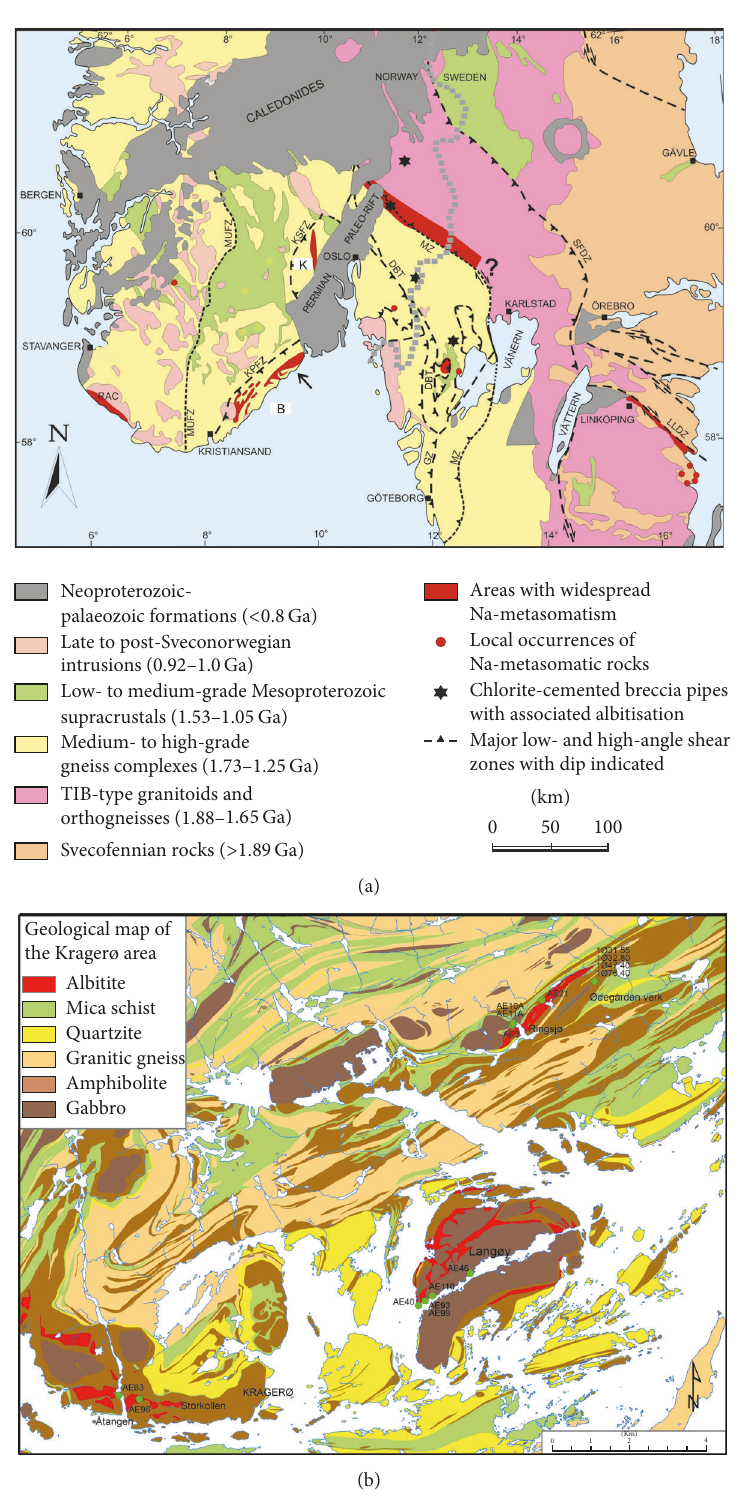
Figure 1: (a) Regional geological map of south Norway and Sweden indicating areas of widespread Na-metasomatism [23]. Arrow indicating the study area (Figure 1(b)). B = Bamble lithotectonic domain; K = Kongsberg-Modum lithotectonic domain; RAC = Rogaland Anorthosite Complex; KPFZ = Kristiansand-Porsgrunn Fault Zone; KSFZ = Kongsberg-Sokna Fault Zone; MZ = Mylonite Zone; DBT = Dalsland Boundary Thrust; GZ = G¨otaelv Zone; SFCZ = Sveconorwegian Frontal Deformation Zone; and LLDZ = Link¨oping-Lofthammer Deformation Zone. (b) Geological map of the investigated Kragerø area in the Bamble lithotectonic domain with sample